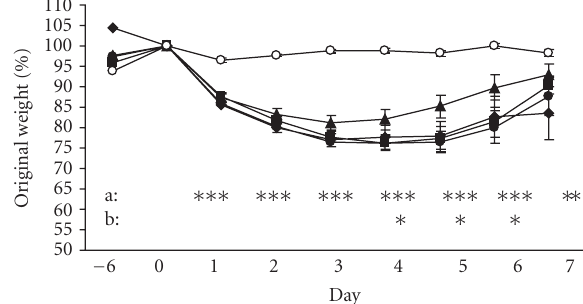
Figure 1: Body weight changes. Changes in body weight are ex- pressed as a percentage of the original weight on day 0. Values are arithmetical means ± SEM. Statistical significance of the di ff er- ences between the group of untreated colitic animals (TNBS group) and other groups of animals was assessed using the Student t test; ∗ P ≤ . 05, ∗∗ P ≤ . 01, ∗∗∗ P ≤ . 001. A ( (cid:2) ): colitic animals fed with the combination of 0.4% thyme and 0.2% oregano oils; B ( (cid:3) ): col- itic animals fed with the combination of 0.2% thyme and 0.1% oregano oils; C ( • ): colitic animals fed with the combination of 0.1% thyme and 0.05% oregano oils; D ( (cid:4) ): animals with TNBS- induced colitis; E ( ◦ ), control sham animals; a: statistical di ff erence between the D and E groups; b: statistical di ff erence between the D and B groups.